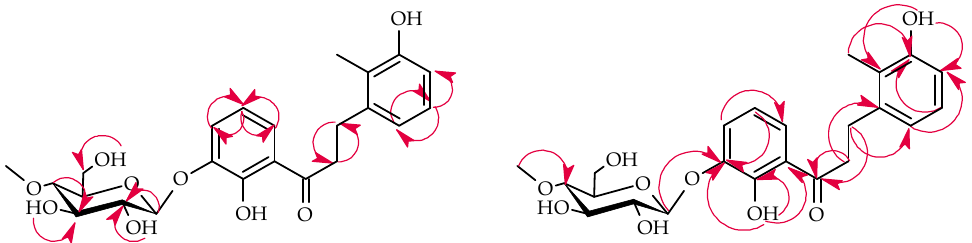
Scheme 3. Key COSY ( on the left ) and HMBC ( on the right ) correlations for the structure elucidation of product ( 3a ).